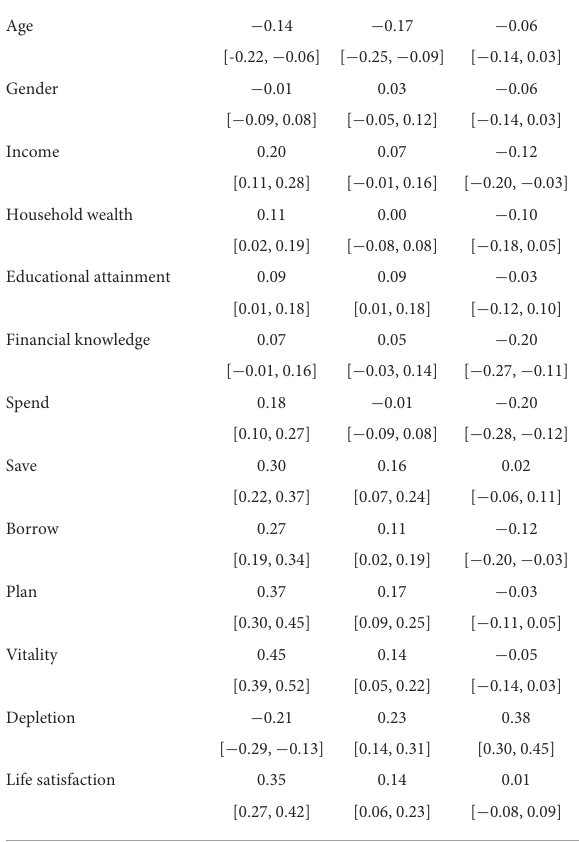
TABLE 9 Study 2 correlations of SDT financial motivations ( N = 534). Autonomous